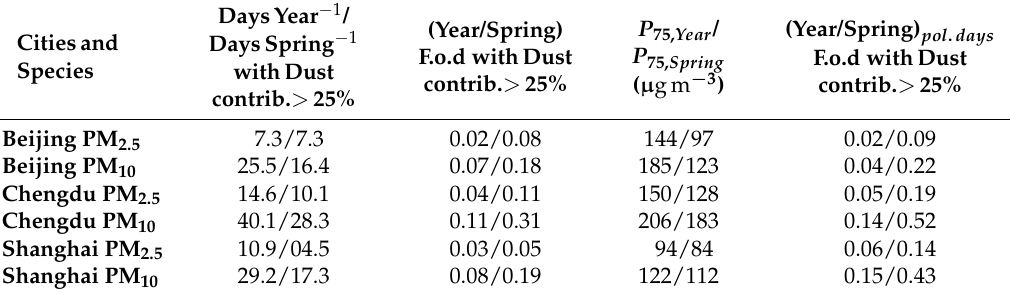
Table 6. Fraction of days when the dust contributions to daily PM 2.5 or PM 10 are at least 25%. These values were calculated for Beijing, Chengdu and Shanghai, and for various samples: all days in 2011, 2013 and 2015, only for the spring season, for days with the largest pollution (in terms of PM 2.5 and PM 10 respectively), for these latter days, but only during spring. As an example the table reads as follows: For Chengdu, during the 25% most polluted days in spring 2011, 2013 and 2015, 52% of days displayed dust contributions larger than 25%. P 75, Year / P 75, Spring indicates the PM 10 75th percentiles value. They are threshold values, above which a day is considered as one of the 25% most